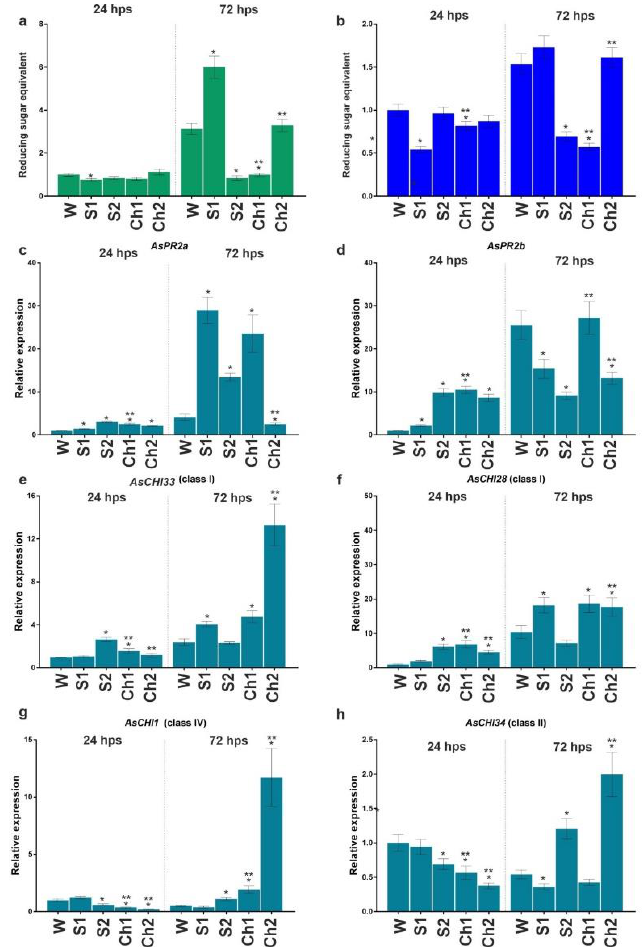
Figure 5. Total chitinase ( a ) and β-1,3-glucanase ( b ) activities and the expression of AsPR2a ( c ), AsPR2b ( d ), AsCHI33 ( e ), AsCHI28 ( f ), AsCHI1 ( g ), and AsCHI34 ( h ) genes in garlic roots soaked for 24 h in water (W), control solutions (S1, S2), and chitosan (Ch1, Ch2). The expression data were normalized to GAPDH and UBQ mRNA levels, statistically analyzed with Graph Pad Prism version 8, and presented as the mean ± SE (n = 3) from three technical replicates of three biological replicates. * p < 0.01, compared to W control; ** p < 0.01, Ch1/2 compared to S1/2.